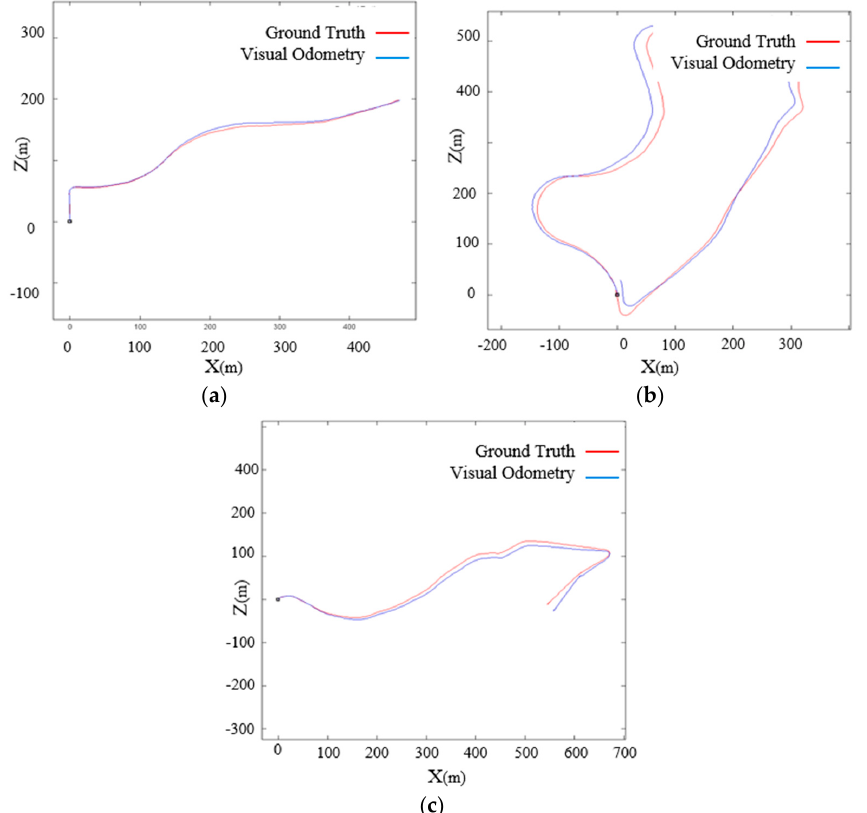
Figure 14. ( a ) Estimated result with fewer curves area; ( b ) The result with a high number of curves area; ( c ) The result with sharp